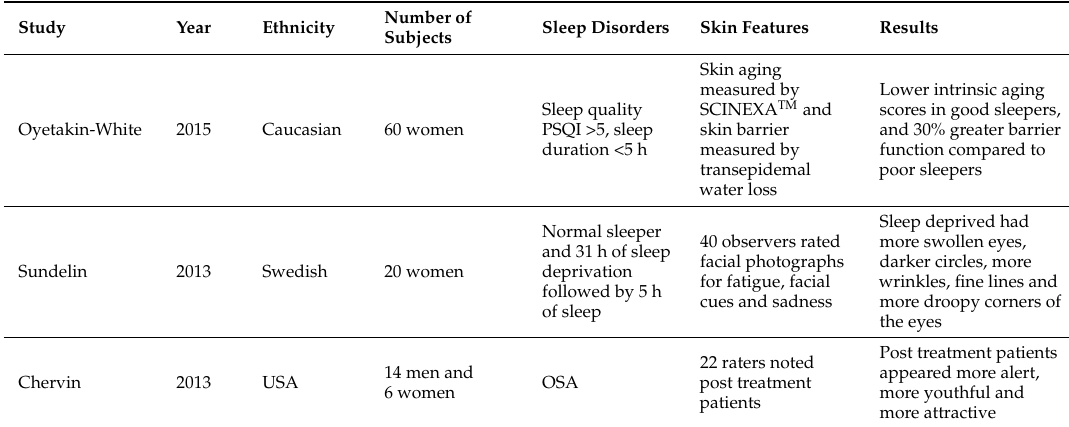
Table 2. Studies with skin aging, facial appearance and